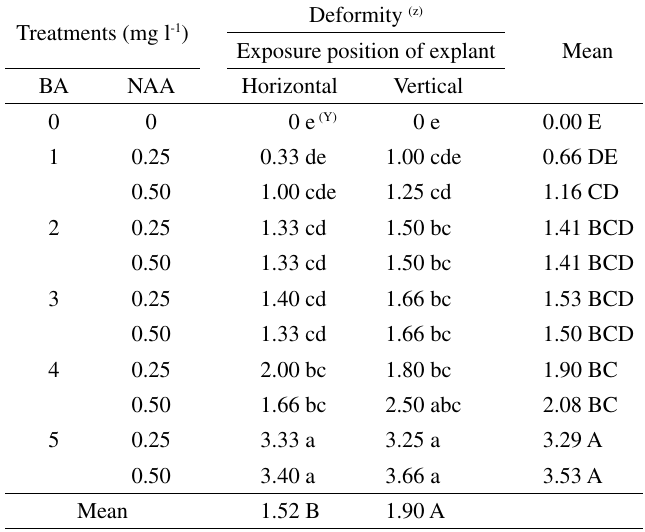
Table 10 - The interaction effect of different concentrations of BA and NAA, and exposure position of explants on deformity in ‘Variegated’ Deformity Treatments (mg l -1 )